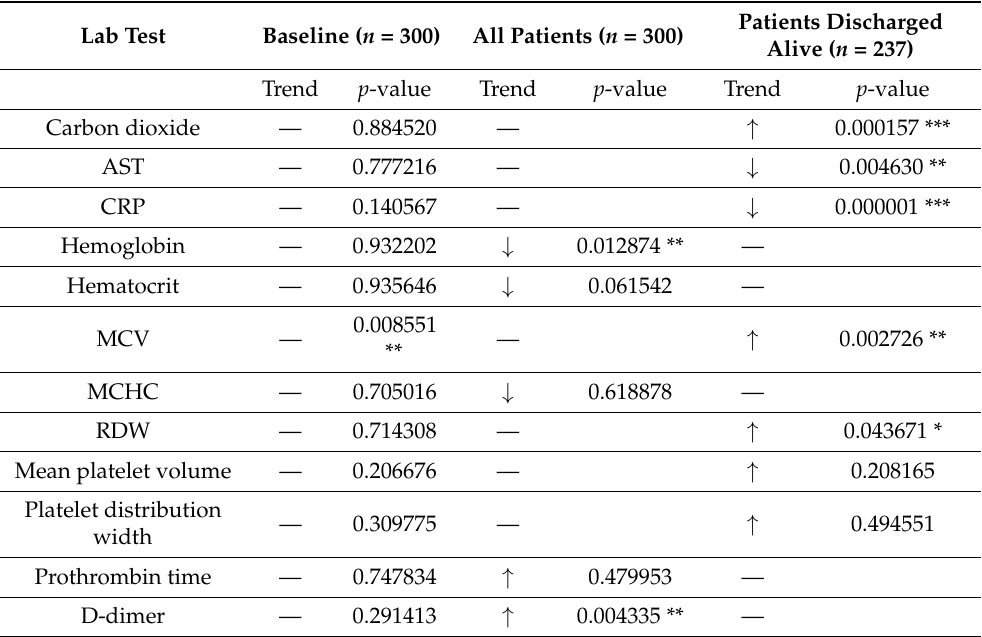
Table 5. Observed trends for the short-term effects of different doses of tocilizumab on COVID-19 patients and the comparisons between